Question: Which kind of chart has been used to present this data?
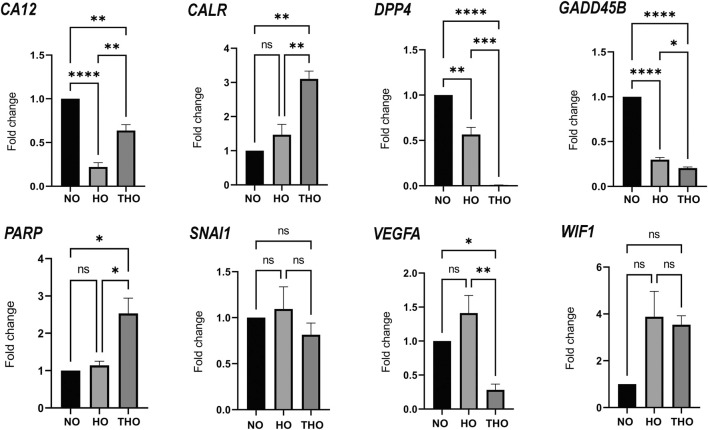
Answer: line